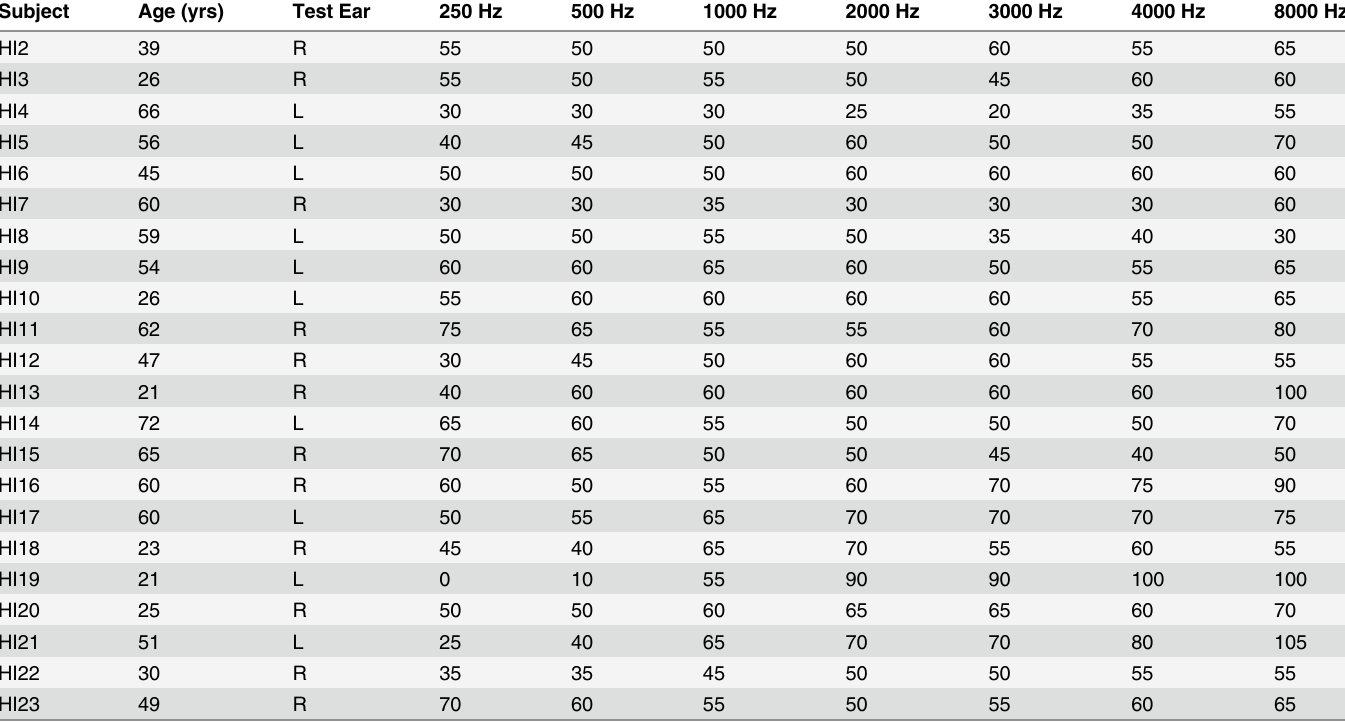
Table 1. Audiometric thresholds for hearing-impaired (HI) subjects in dB